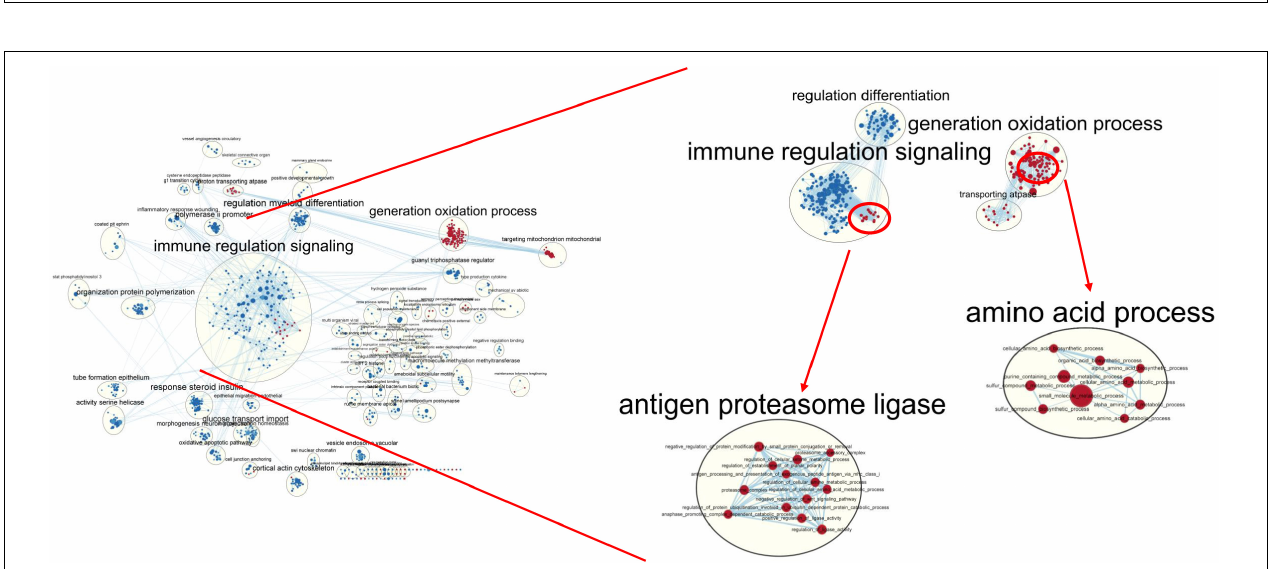
FIGURE 12 | Global network of enrichment results of turquoise module genes. The red and blue nodes indicate that the pathway is upregulated in the skin and blood, respectively.